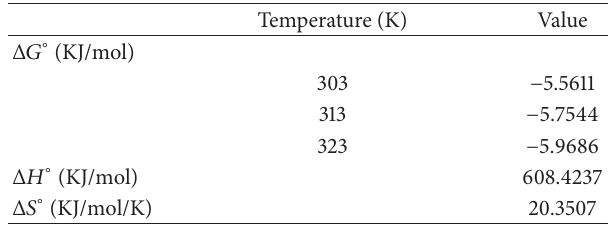
Table 3: Thermodynamic parameters of arsenic sorption on acti- vated Moringa oleifera